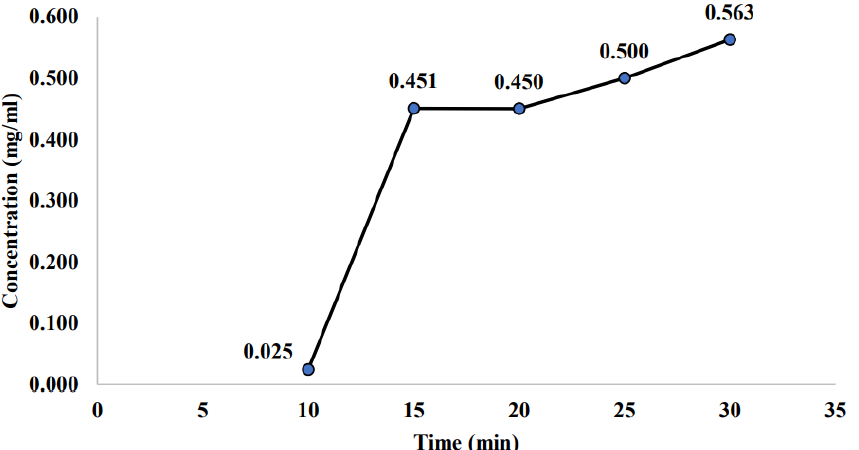
Figure 4. Saponin concentration of non-sterilized sample at different concentration times.